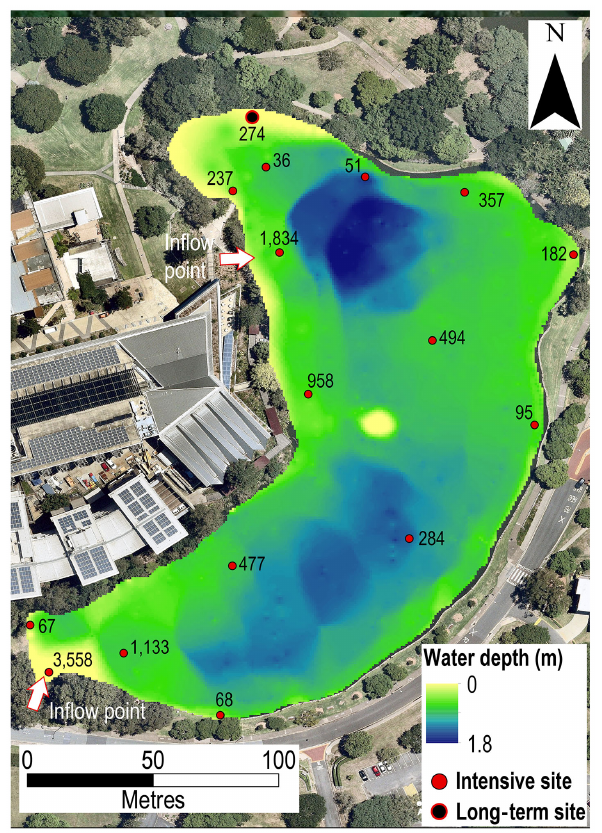
Figure 4. Sampling site location and chamber emission rates (mgm − 2 d − 1 ) across an urban lake (St Lucia 1) relative to water depth and proximity to storm water inflow